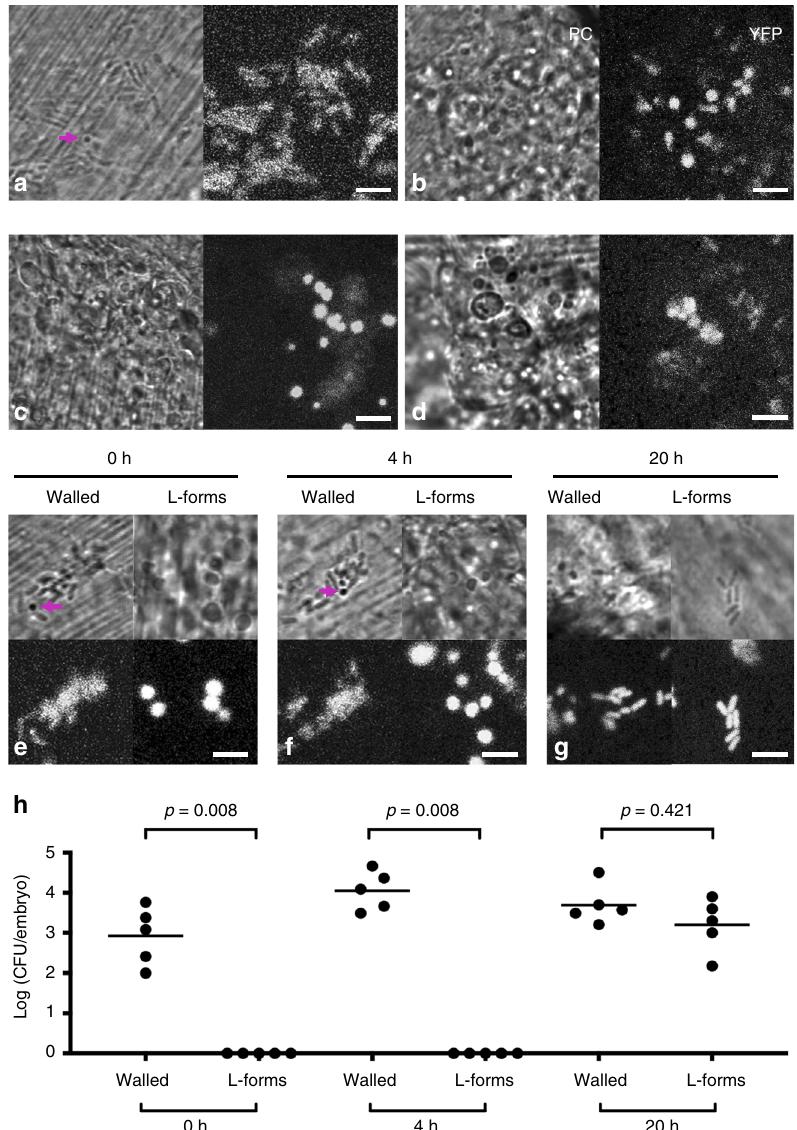
Fig. 5 L-form switching in the zebra fi sh embryo. a , b Walled E. coli ST144-YFP was injected into the tail fi n of zebra fi sh larvae in the presence ( b ) or absence ( a ) of 0.4 mg/ml phosfomycin and visualised by phase contrast (PC) or fl uorescence microscopy (YFP). The magenta arrow in ( a ) points to a bacterium that appears to have adopted a round shape in the absence of antibiotic. c , d ST144-YFP E. coli L-forms induced in vitro with 0.4 mg/ml phosfomycin were injected into the tail fi ns of zebra fi sh larvae in the presence of 0.4 mg/ml phosfomycin and visualised by microscopy immediately post- injection ( c ), or following an overnight incubation ( d ). e – g ST144-YFP E. coli walled or in vitro induced L-form bacteria were injected in the absence of the antibiotic and visualised 0 h ( e ), 4 h ( f ) or 20 h ( g ) post infection. h The bacteria were enumerated by homogenising fi sh embyos and plating out on NA 0, 4 or 20 h post infection. Each circle represents recovered bacteria from an individual larva. Representative data from two independent experiments (one with two and one with three larvae). Mean (horizontal bars) is shown. The p values were determined by non-parametric Mann – Whitney test. Signi fi cance was de fi ned as p < 0.05. Scale bars = 5 µ m. Source data for Fig. 5h are provided as Source Data fi colonies were picked for 16S rRNA sequencing. For patient UTI343, 20 colonies with agarose at 0.2 or 1% as indicated, were used for osmoprotection. Fresh urine were subjected to MLST sequencing prior to and after fi ltration. Samples of fresh of a healthy individual passed through a 0.2µm cut off fi lter (supplemented with urine (500µl) were concentrated 20× by centrifugation at 8000 × g for 2 min and a 0.2% agarose for time-lapse microscopy) was used for urine survival assays. 1 µl volume from each sample was examined immediately by phase contrast Phosphomycin was added at 400µg/ml where indicated. The cultures were incu- microscopy. Samples of 250 µl urine were fi xed with 4% paraformaldehyde, fol- bated at 37 or 30°C as indicated. yfp plasmid PMCL200 28 was introduced to lowed by overnight incubation at 4°C. Paraformaldehyde was removed and the electrocompetent ST144 cells by electroporation at 2.5µF, 200 Ω , 2.5V in a Gene samples were stored in 50% ethanol/50% PBS at − 20 °C. Pulser Xcell electroporation unit (Bio-Rad) to create strain ST144-YFP. Urine processing . Urine processing and scoring for the presence of L-forms was blinded. Fresh urine samples obtained from patients were streaked using 10µm loops on CPS Elite plates and incubated overnight at 37 °C. Aliquots of 2 ml were fi ltered through 0.45 µm cut off fi lters onto 5 ml of LM medium in 30ml universal tubes, supplemented with 0.2% agarose and incubated at 30 °C for up to 1 month. Samples cultured in semi-liquid medium were re-streaked on NA plates and single